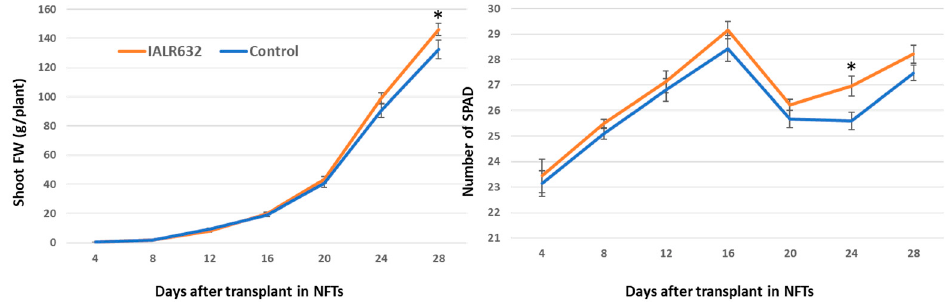
Figure 3. Effects of IALR632 inoculation on Green Oakleaf lettuce growth rates and SPAD for 4 weeks (23 September 2021 to 21 October 2021). * on the column means statistically significant difference at p < 0.05.